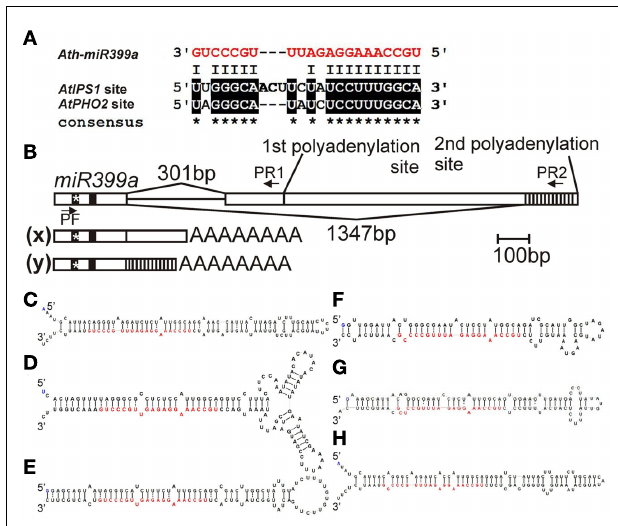
FIGURE 2 | (A) Alignment of mature Arabidopsis miR399a with miR399 binding site present in AtIPS1 sequence and in 5 (cid:2) UTR of AtPHO2 mRNA (binding site no. 2 according to Lin et al., 2008); (B) Arabidopsis miR399a gene structure and its pri-miRNA species.The position of primers used for amplification of both pri-miR399a isoforms is marked by arrows. (x) pri-microRNA399a isoform marked in Figure 1E with an x (primers: PF and PR1), (y) second pri-microRNA399a isoform (primers: PF and PR2), after alternative 3 (cid:2) splice site recognition.The position of mature microRNA is depicted by a vertical black line, the position of the microRNA ∗ is depicted by ∗ symbol on a vertical black line; (C–H) Stem-loop structures of Arabidopsis microRNA399 precursors with Minimum folding Free Energy (MFE); mature microRNA399 is marked by red fonts; (C) pre-miR399a (dG =− 51.60kcal/mol, one of two structures with the same energy, MI0001020 – accession number in the miRBase, www.mirbase.org); (D) pre-miR399b (dG =− 61.70kcal/mol, MI0001021); (E) pre-miR399c (dG =− 57.89kcal/mol, MI0001022); (F) pre-miR399d (dG =− 45.40kcal/mol, MI0001023); (G) pre-miR399e (dG =− 48.70, one of six structures with the same energy, MI0001024); (H) pre-miR399f (dG =− 49.60, one of